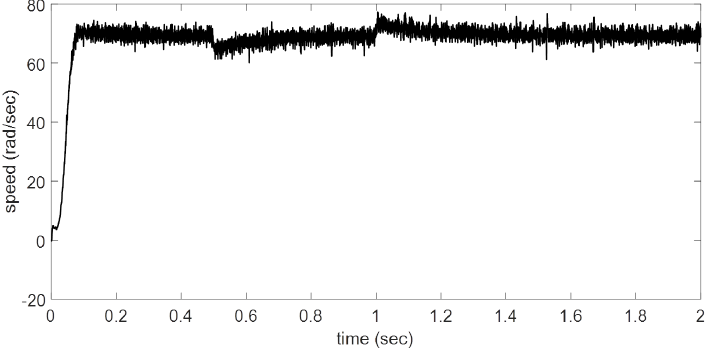
Figure 9. Rotor speed performance for reference tracking, case c .